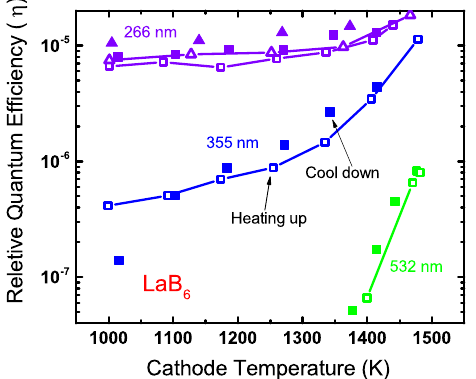
FIG. 12. Relative QE of LaB 6 which is obtained with 266, 355 and 532 nm laser irradiation as the function of the cathode temperature during heating up and cooling down processes.